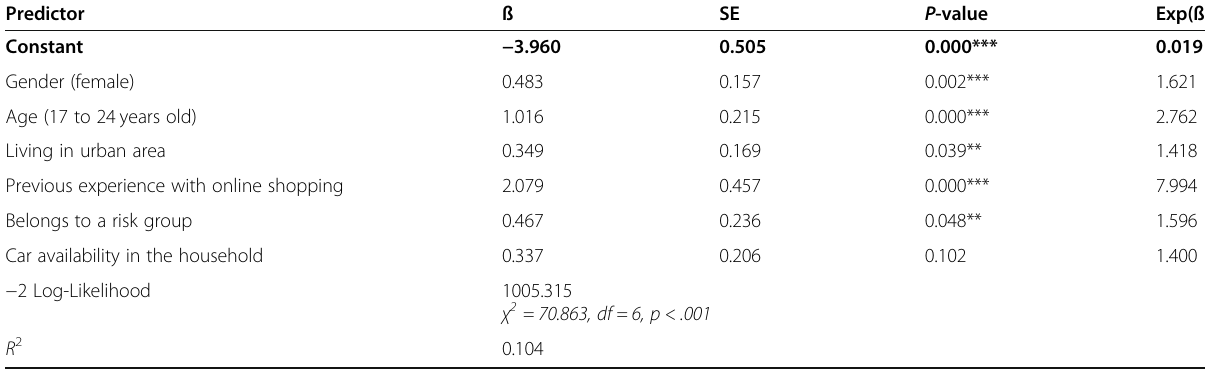
Table 2 Summary of binary logistic regression analysis for variables predicting whether an individual belongs to the group of people who purchase during the Coronavirus pandemic products online instead of in stores Predictor ß SE P -value Exp(ß) Constant −